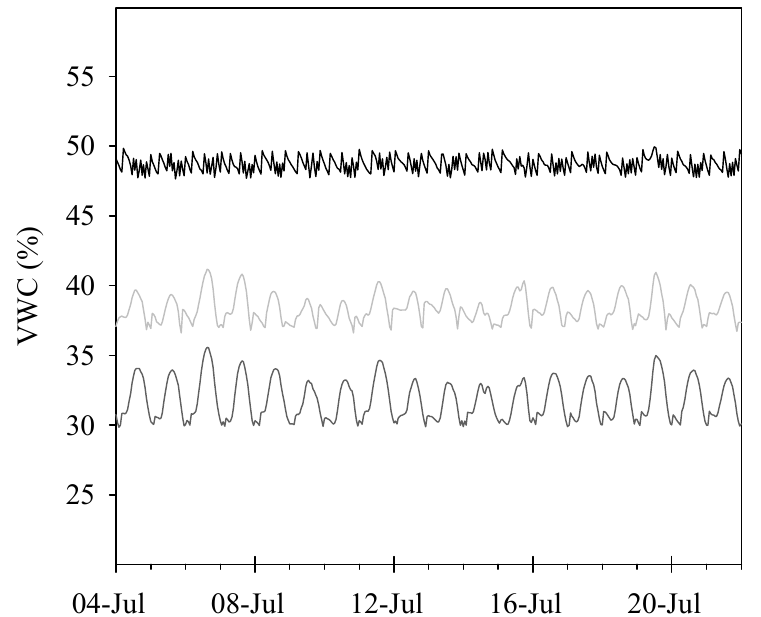
Figure 3. Fluctuations in the substrate moisture when irrigating with small volumes of water. Lines represent three different volumetric water contents (VWCs): 49.28% VWC (control, black line), VWC 38.44% (VWC39%, light grey line), and VWC 32.16% (VWC32%, dark grey line).